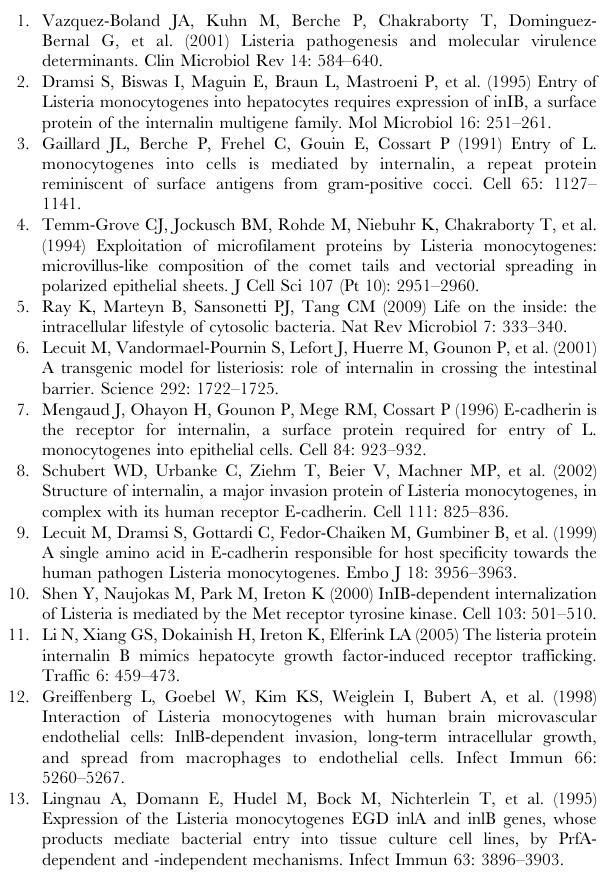
MDCK cells are numbered. Time in minutes, m, is indicated.